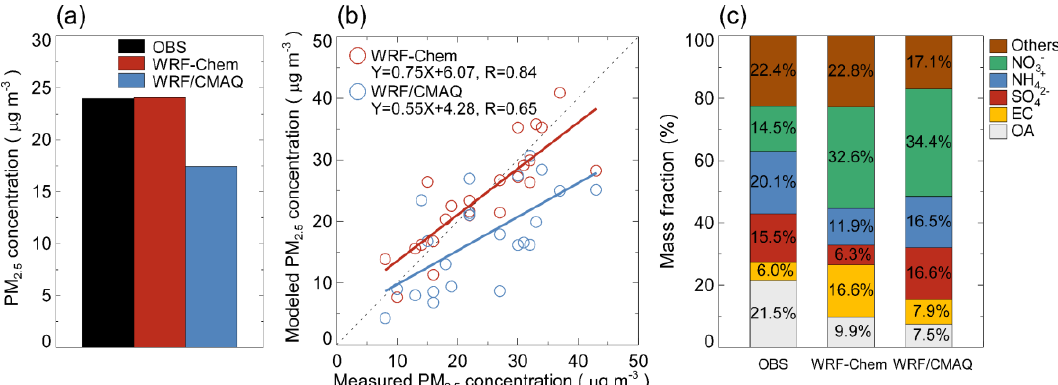
Figure 14. Comparison of the simulated and measured PM 2.5 chemical components in Seoul, South Korea for ( a ) 24-days mean PM 2.5 concentrations, ( b ) daily mean PM 2.5 concentrations, and ( c ) fraction of chemical composition. The PM 2.5 concentrations in ( a , b ) include soil dust and sea salt aerosols in the comparison. Table 2. The measured and simulated monthly mean PM 2.5 chemical components over Seoul, South Korea in April 2010. The numbers in parentheses denote the fractional biases.